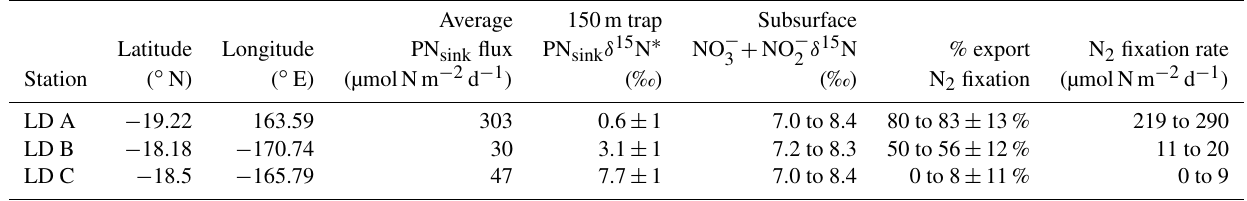
δ 15 N, PN sink δ 15 N, and N 2 fixation rate and contribution to export at the OUTPACE long-duration 2